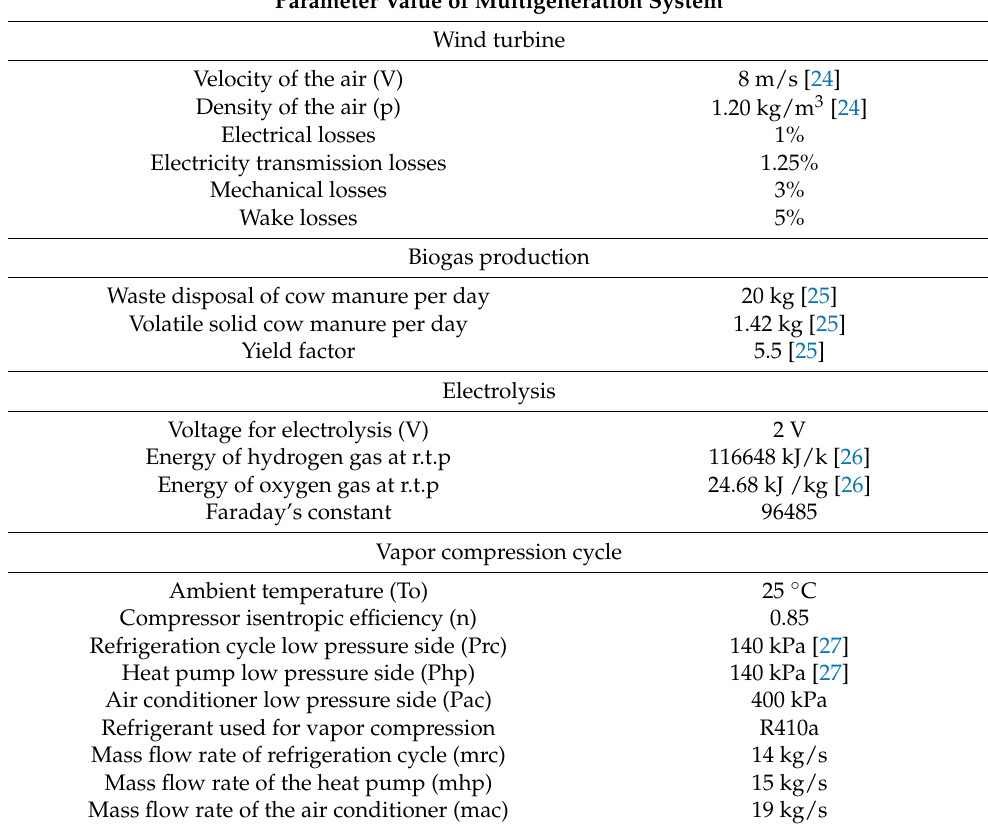
Table 1. Parametric table of multigeneration